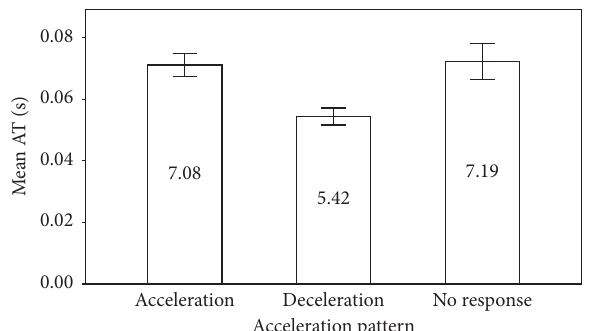
Figure 11: Fitted mean profiles of AT with respect to acceleration pattern.